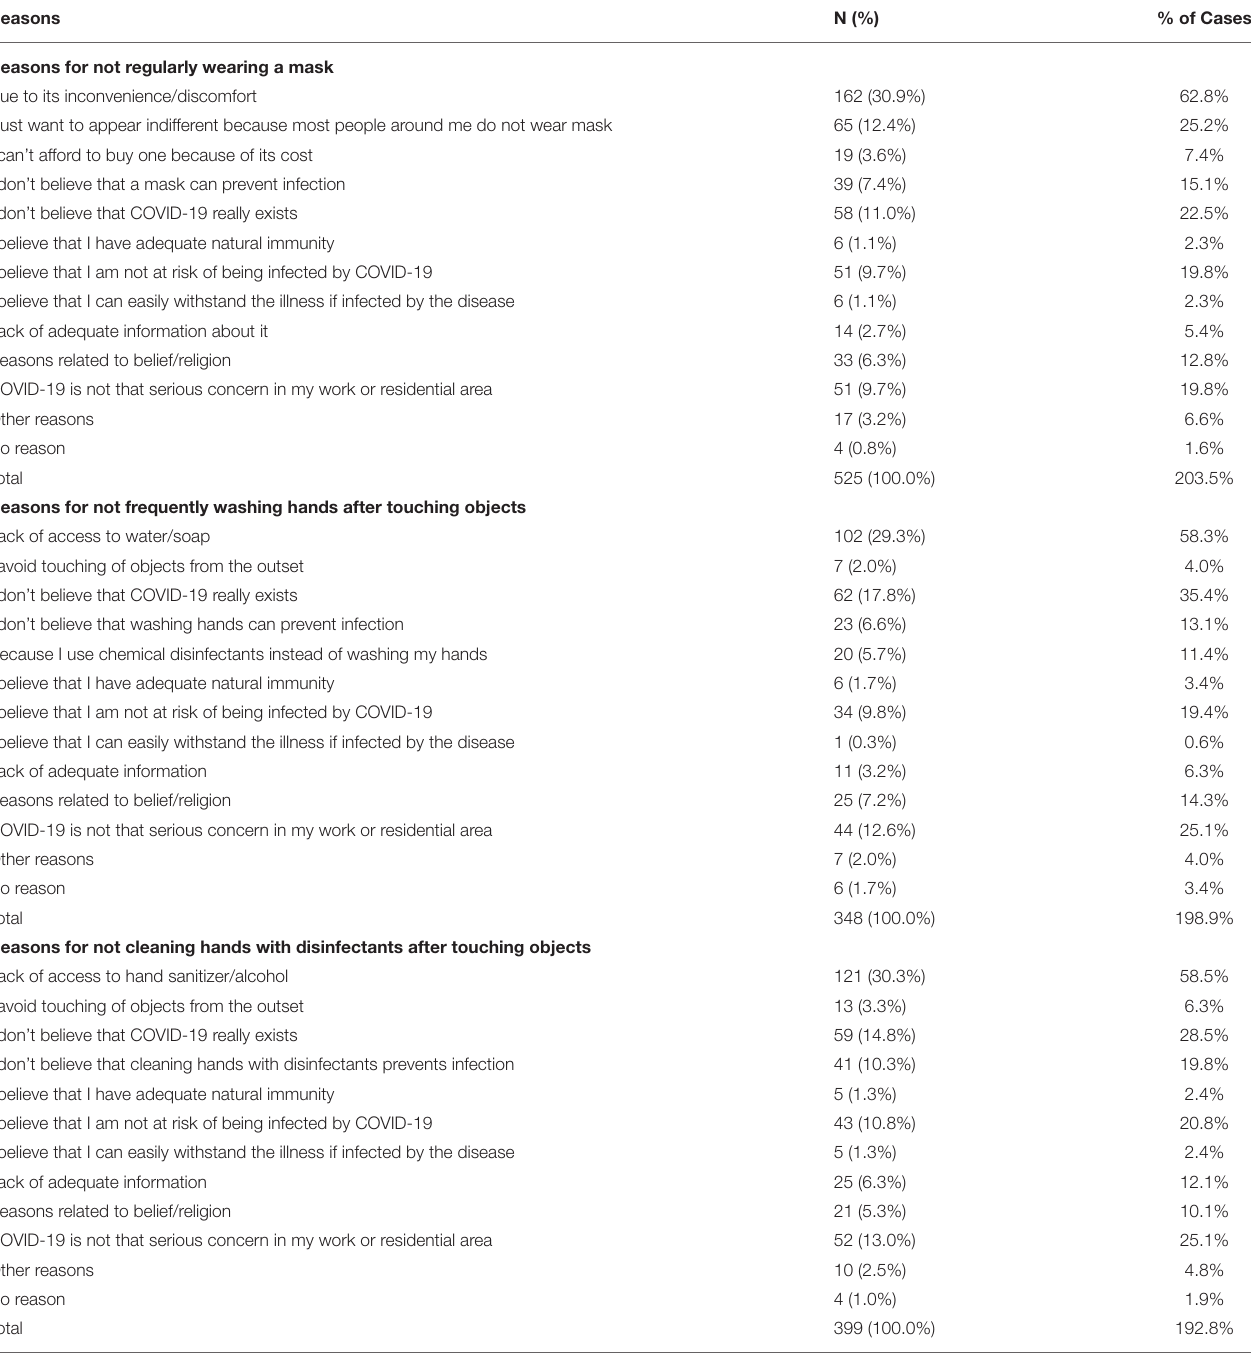
TABLE 3 | Reasons of the respondents for non-compliance to personal protective behavioral recommendations. Reasons N (%) % of Cases Reasons for not regularly wearing a